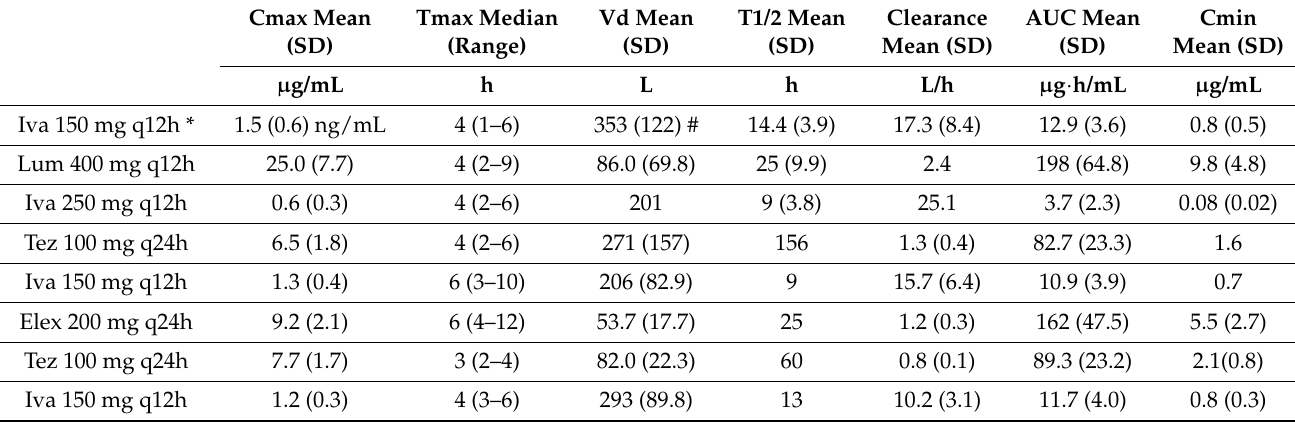
Table 1. Steady state pharmacokinetic parameters for CFTR modulators in a fed state in patients with CF aged 12 years and older. (data from SmPCs and FDA